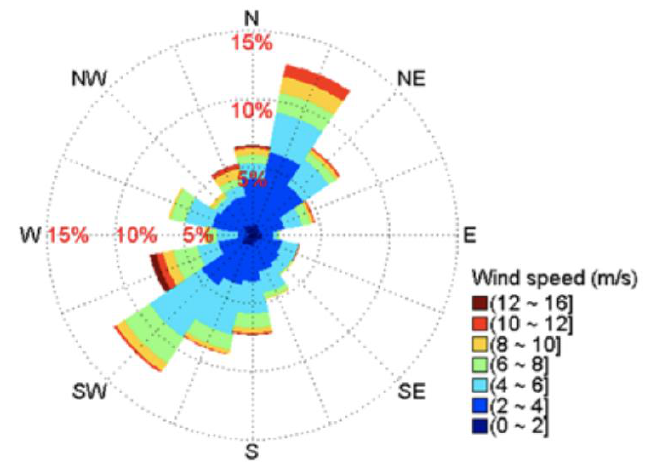
Figure 9. Wind rose for modeling period 1 May to 1 October 2006 [14].